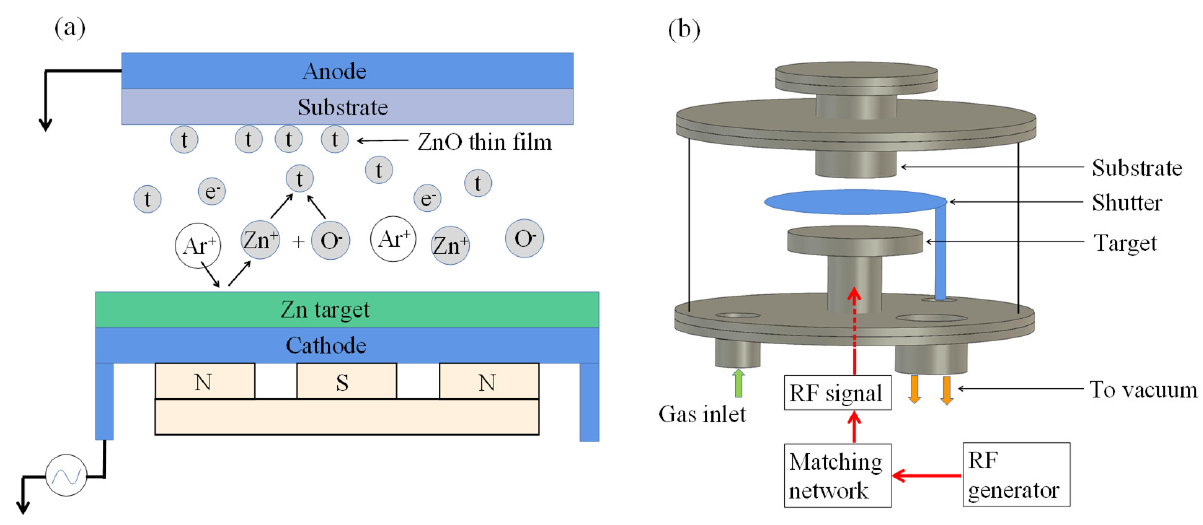
Figure 3. The principle ( a ) and equipment diagram ( b ) of RF magnetron sputtering.